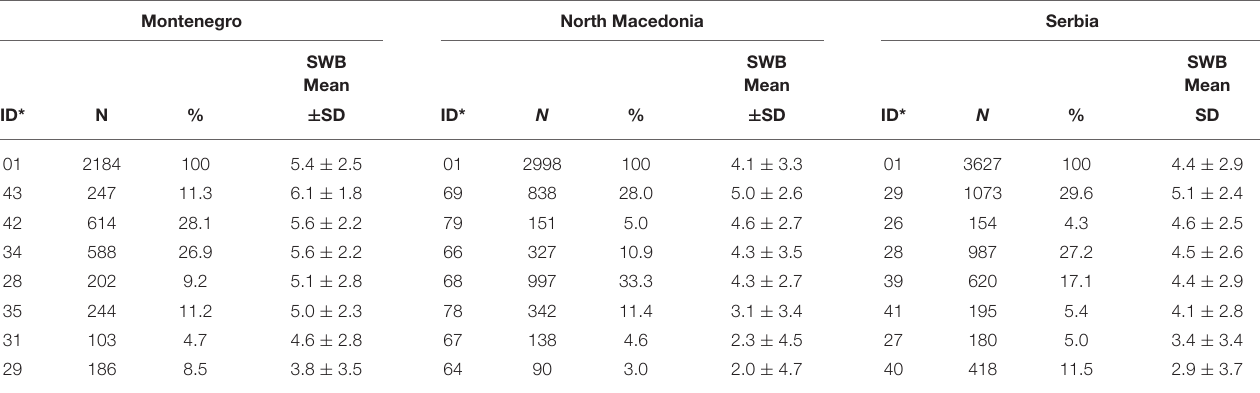
TABLE 5 | Comparison of the end-nodes (defined women groups) of the three countries under consideration (for details, see the iC&RT figures in Annexes I–III, and the statistical evaluation in Annex IV ).